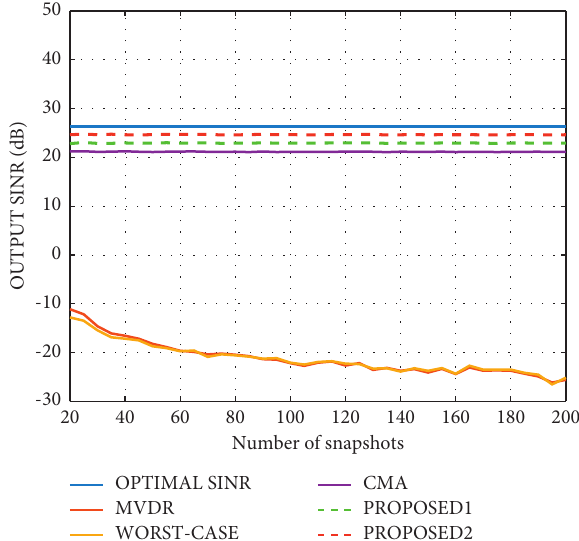
Figure 6: Received signal coherence: output SINR versus the number of snapshots.